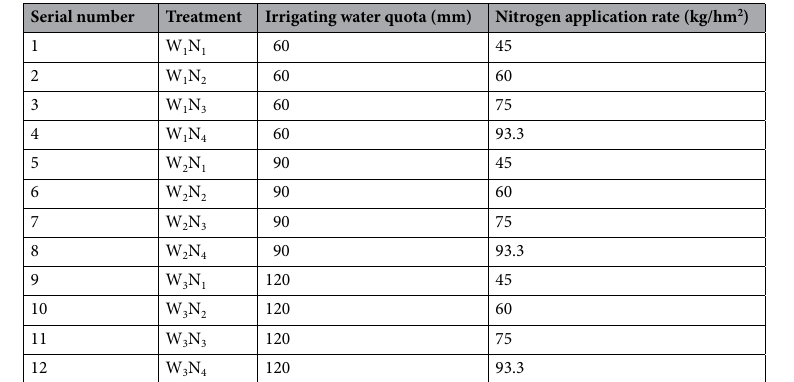
Table 1. Experimental 1 design scheme.